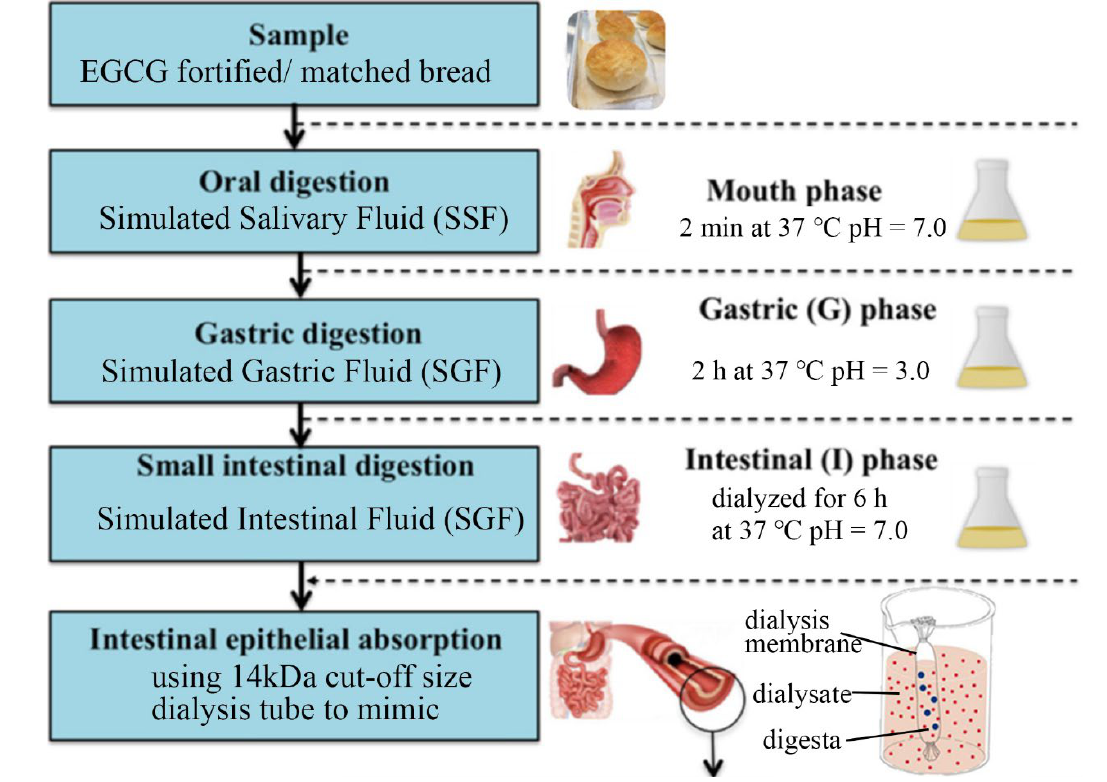
Figure 1. A schematic flowchart of in vitro simulated digestion and dialysis.